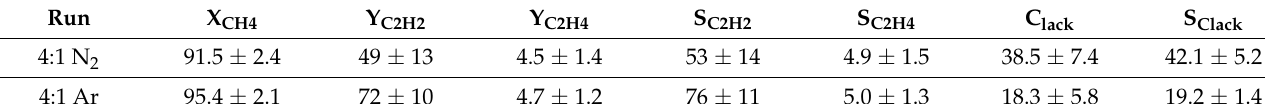
Table 2. Nitrogen impact on the process parameters.